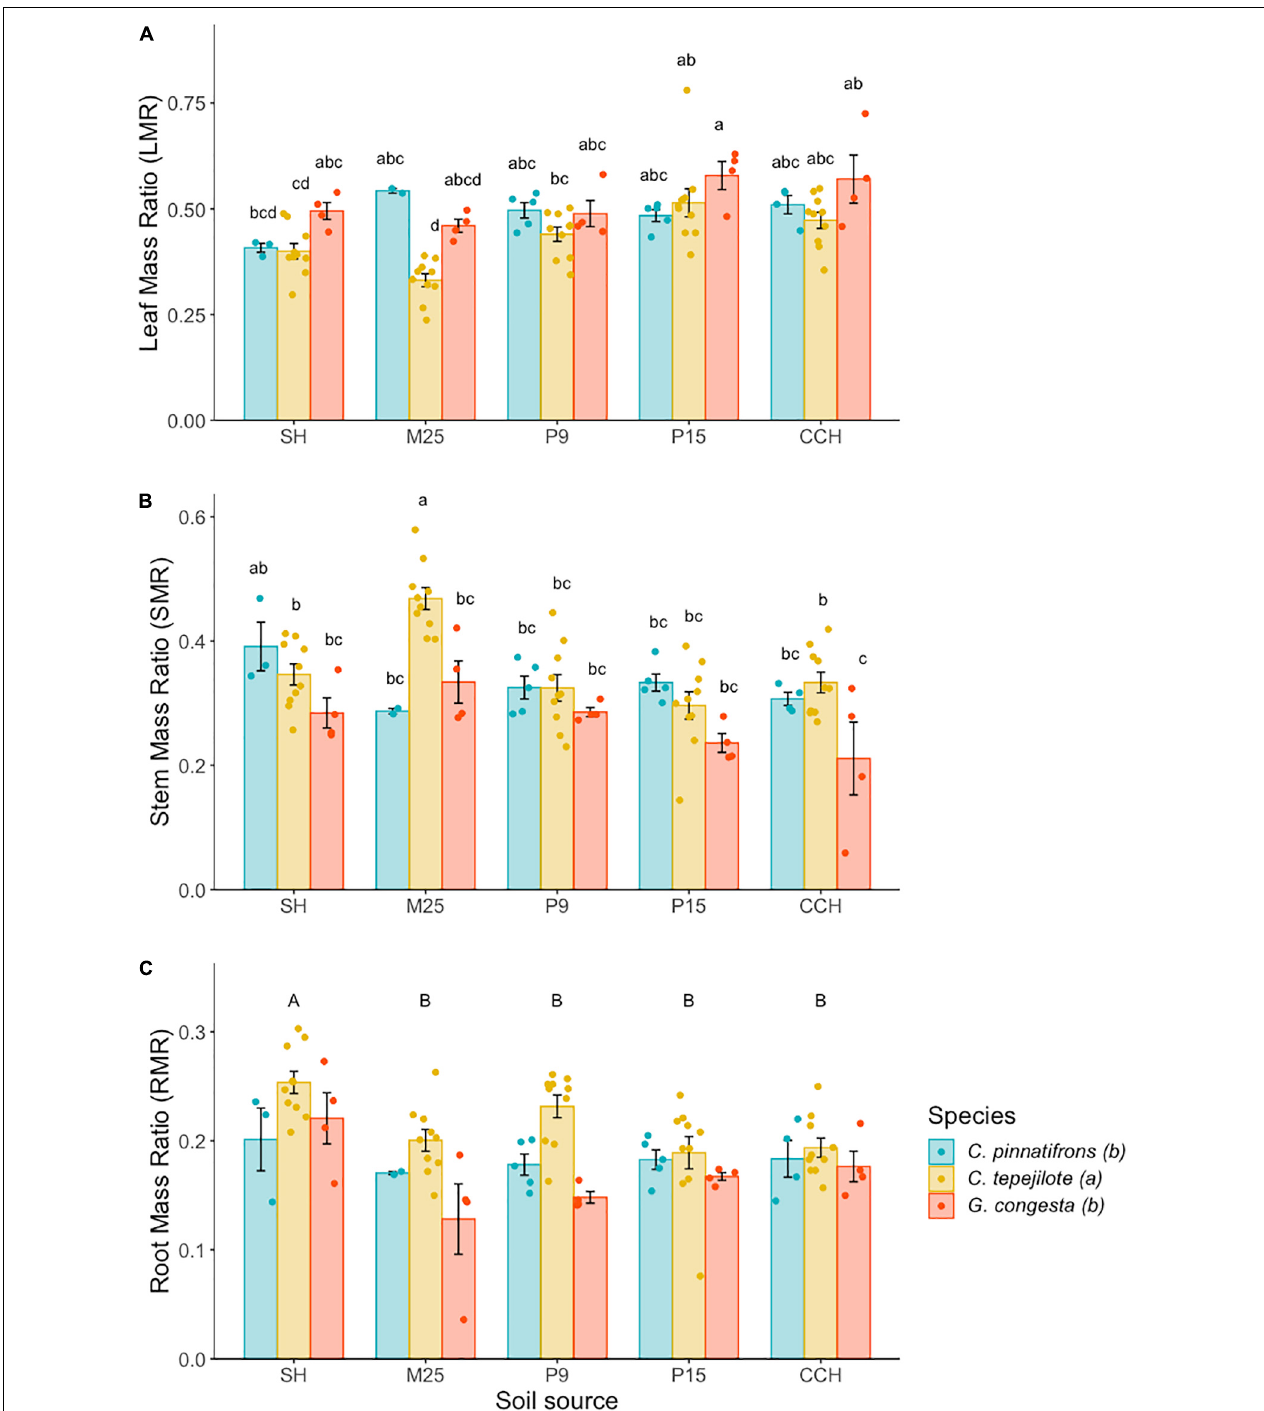
FIGURE 3 | Biomass allocation (mean ± SE) of seedlings growing in soil from five sites along a soil nutrient gradient. (A) Leaf mass ratio (LMR), (B) Stem mass ratio (SMR), and (C) Root mass ratio (RMR). Soil is sourced from five sites across a soil nutrient gradient and sites are ranked and listed in order of increasing overall soil nutrition. Different letters above the bars indicate statistically significant different means according to Tukey’s test ( P < 0.05), with lower case letters representing differences among species *soil source combinations and capital letters representing differences among soil sources. The legend represents species fill color for all panels and the letters represent species differences for RMR only. *Represents the interaction between species and soil.